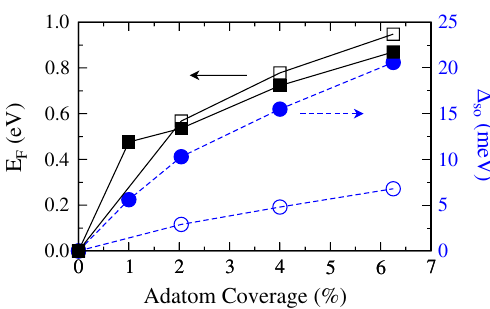
(circles) so (squares) mea- F